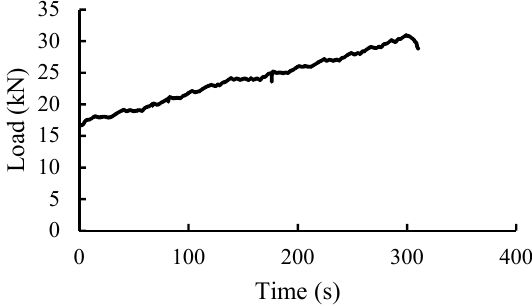
Figure 19. Loading curve of vertical jack of Hg specimen. Table 7. Vertical force of test piece with geotextile on the contact surface.